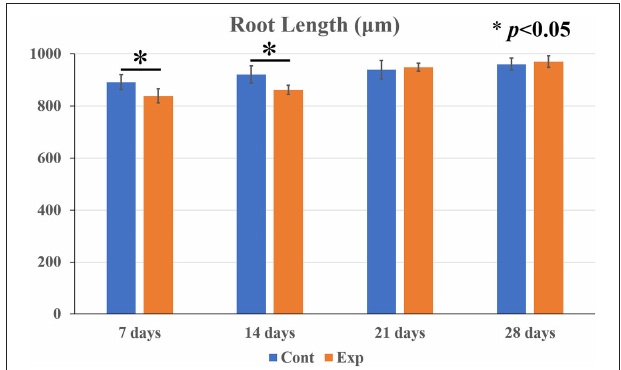
FIGURE 5 | Comparison of postoperative root elongation between the experimental and the untreated control groups at 7, 14, 21, and 28 days. Data are expressed as means ± SD. In both the untreated control and the experimental groups with blood clots, gradual root elongation was observed over time. The root length of the control group became elongated from 890 to 950 µ m over time. On the other hand, the root length of the experimental group became elongated from 860 to 940 µ m over time. The root length in the control group was significantly higher than in the experimental group at 7 and 14 days. However, there was no statistically significant difference between the two groups at 21 and 28 days ( n = 7 per group). * p < 0.05.